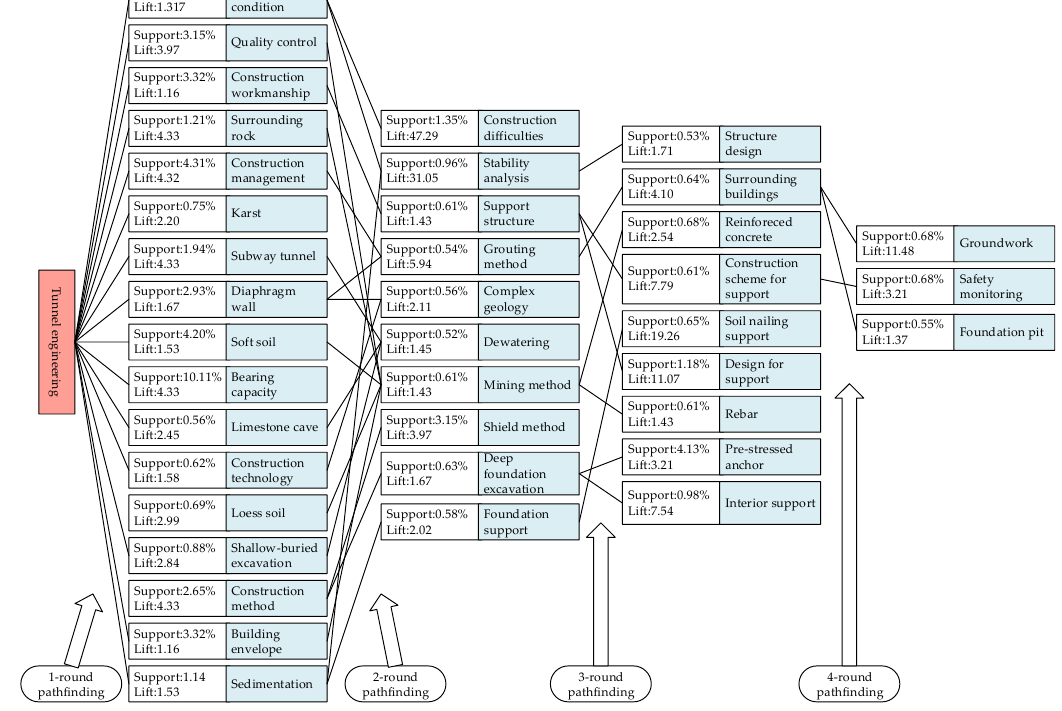
Figure 6. Co-occurrence- based pathfinding process for “tunnel engineering”.